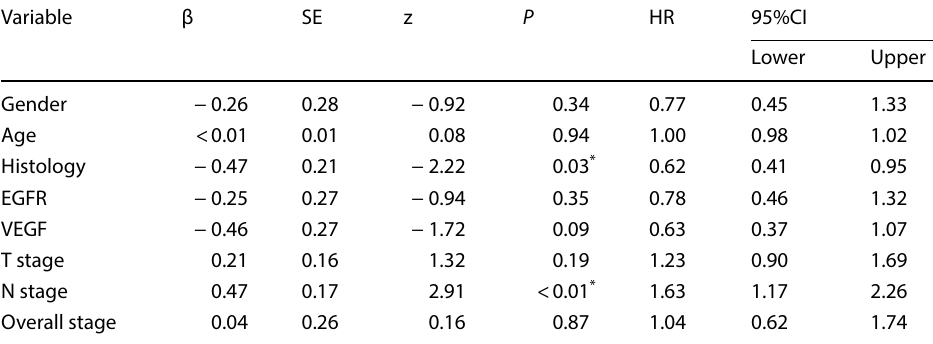
Table 3 Multivariable Cox regression analysis of clinical risk factors of disease progression in the training cohort